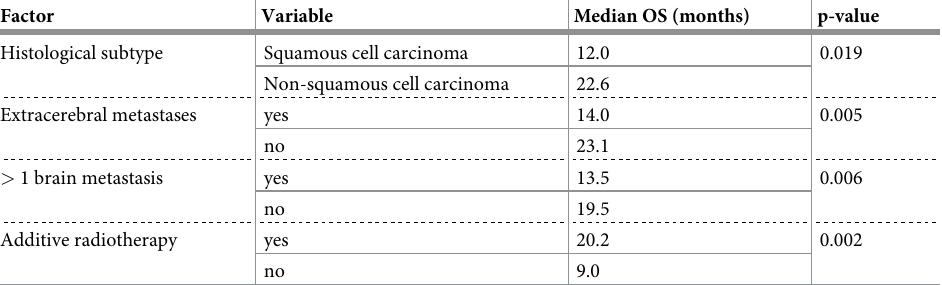
Table 3. Univariate